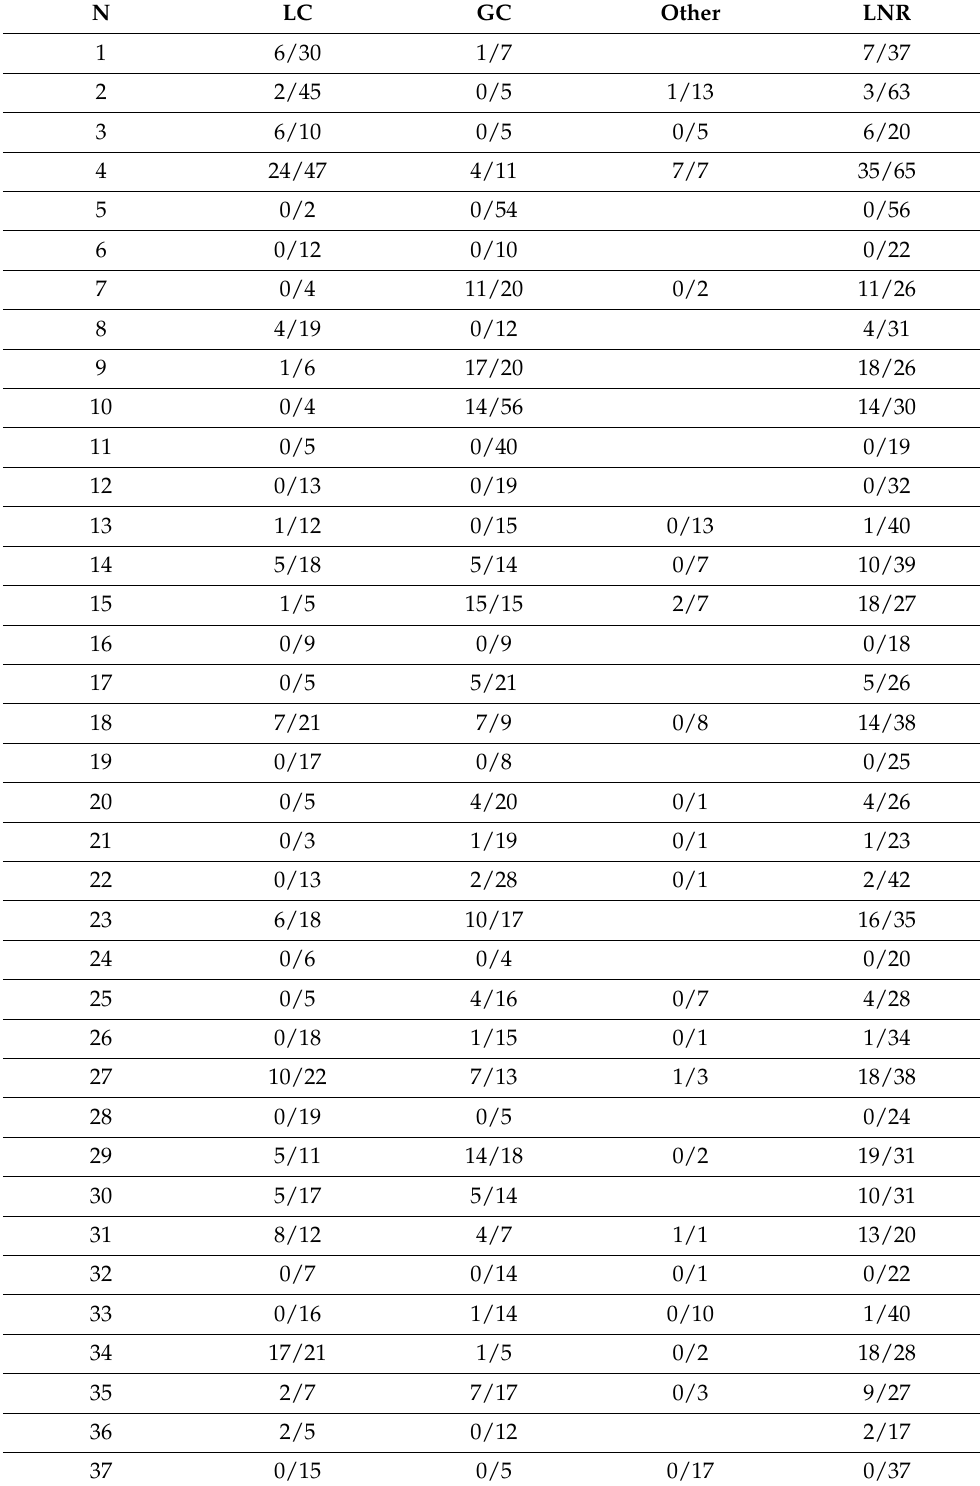
Table 4. Lymph nodes dissection in the control